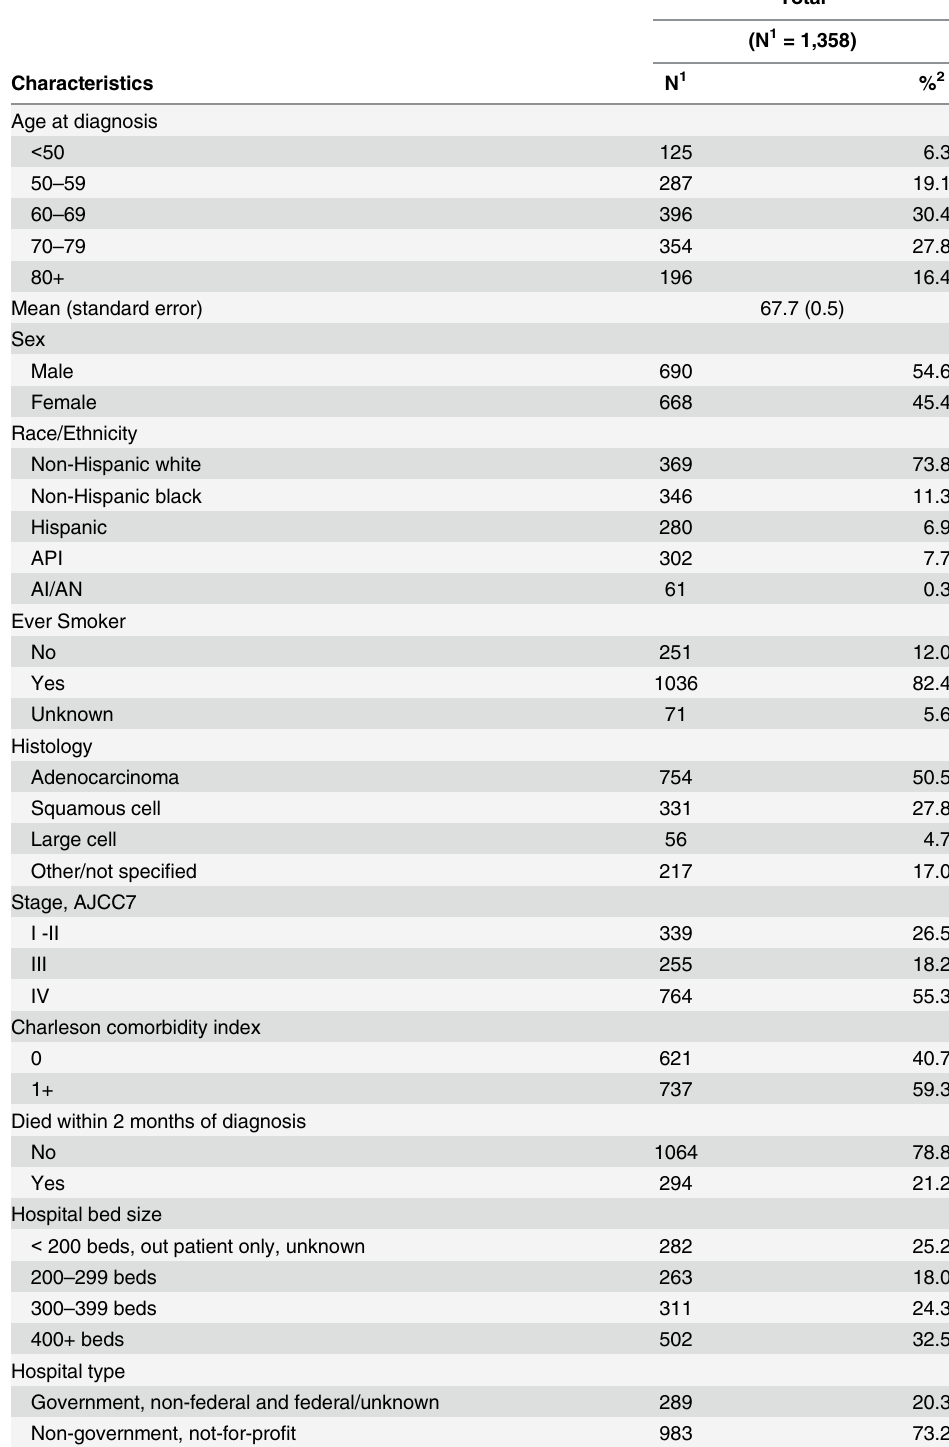
Table 1. Demographics and characteristics among sampled patients diagnosed in 2010 with non- small cell lung cancer, Patterns of Care.